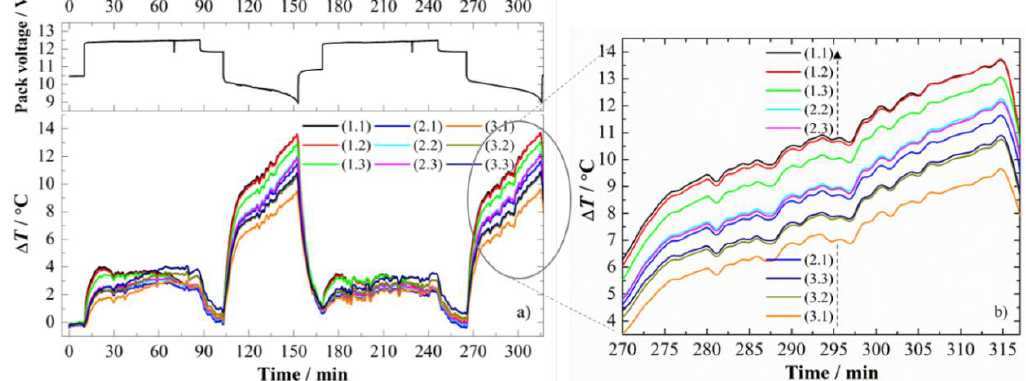
Figure 5. ( a ) Temperature variations with time, during two cycling tests, in all the LiPB surface positions as a function of the pack voltage at 1.4 C discharge rate. ( b ) Enlarged image representing the temperature variations recorded by the 9 FBG sensors located at the LiPB1–LiPB2 interface during the higher discharge rate.